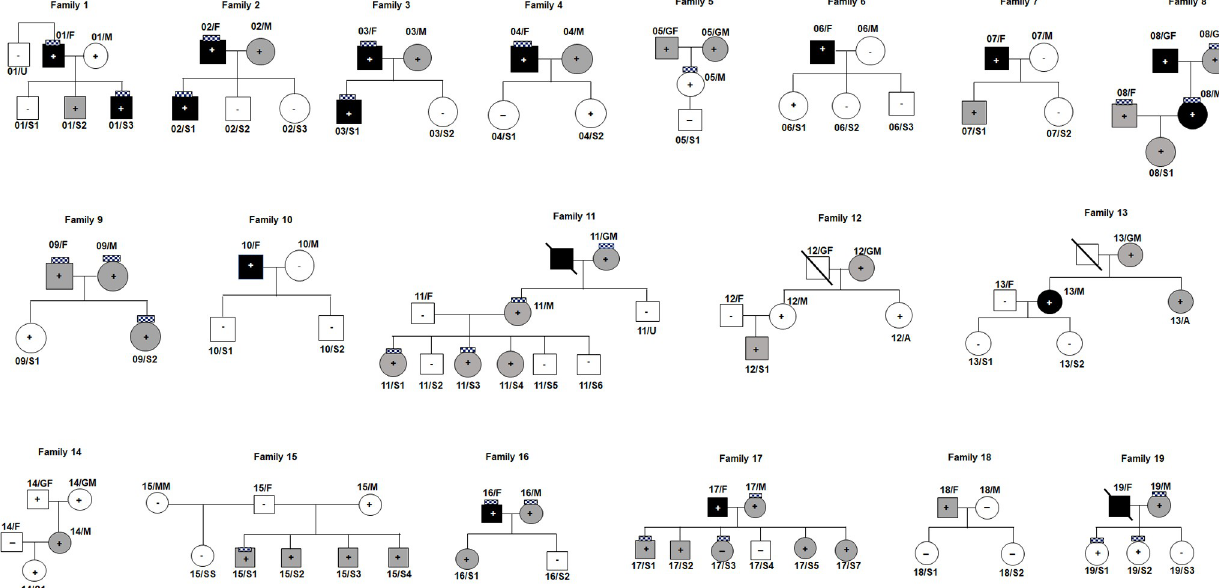
Fig 1. Pedigrees of the eligible families. White squares and circles with the “minus” sign indicate SARS-CoV-2 negative subjects. White squares and circles with the “plus” sign indicate SARS-CoV-2 positive and asymptomatic subjects. Grey squares and circles with the “plus” sign indicate SARS-CoV-2 positive subjects with a mild phenotype. Dark squares and circles with the “plus” sign indicate SARS-CoV-2 positive subjects with severe symptoms. The “chess” symbol stands for subjects with anosmia/ageusia.